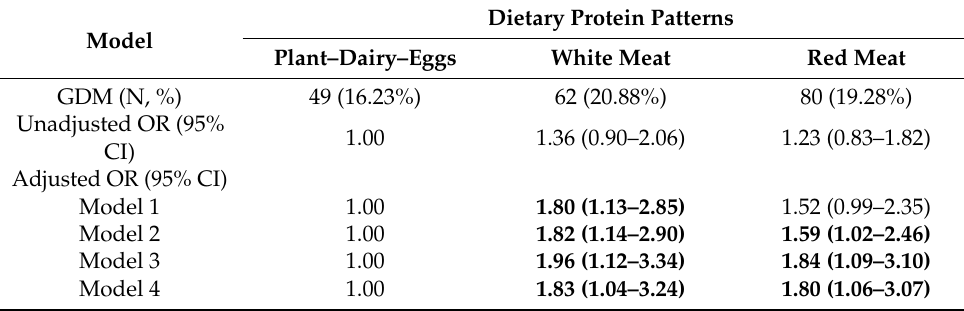
Table 4. The odds ratios of GDM across three dietary patterns. Dietary Protein Patterns Model Plant–Dairy–Eggs White Meat Red